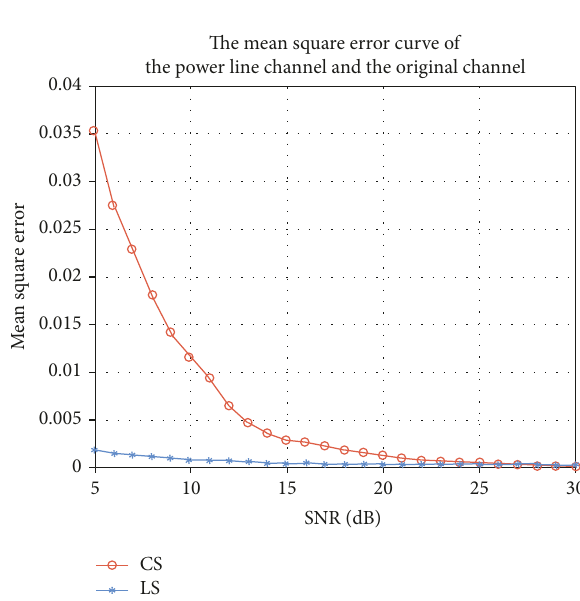
Figure 10: Performance comparison of CS and LS (SNR).